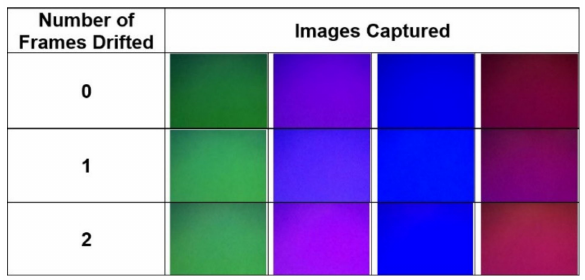
Figure 13. Images captured when the timestamps have reported drifting an integer number of frames. Note that the relevant colours have been re-aligned as a visual aid to ease comparison of colours.